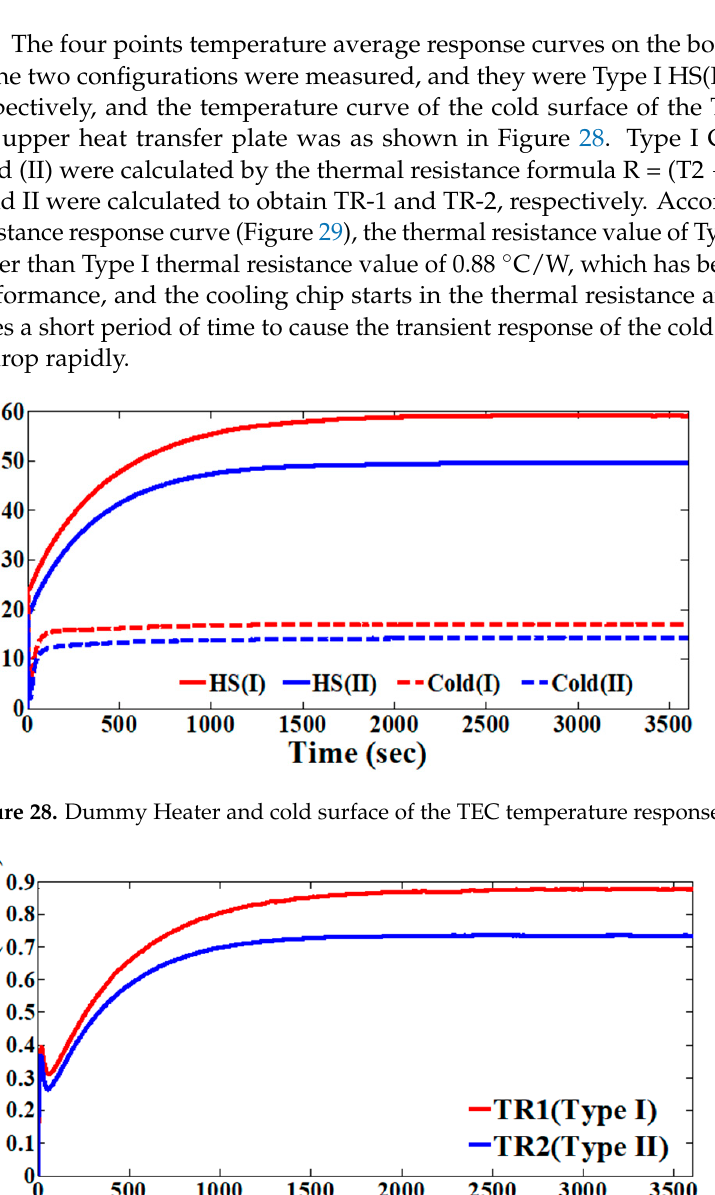
Figure 29. Thermal Resistance. Figure 29. Thermal